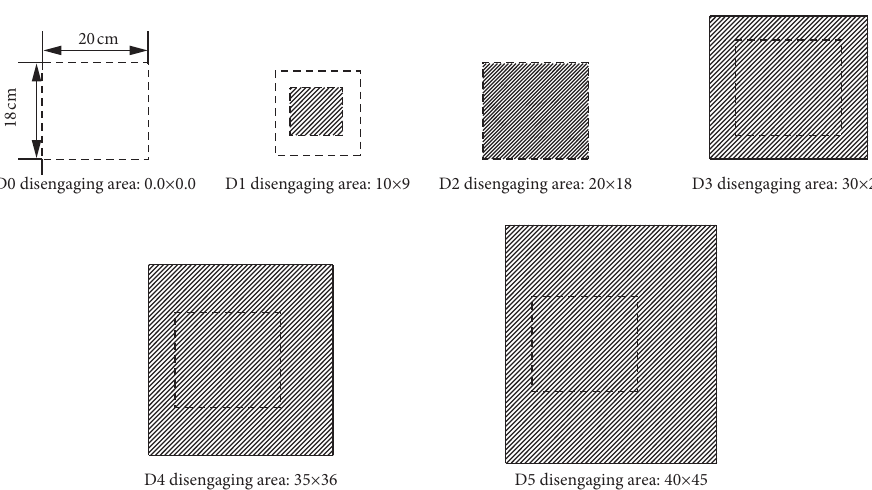
Figure 5: Type of the disengaging area under loading position (not to scale, unit: cm 2 ). Table 2: Responses at the room temperature.